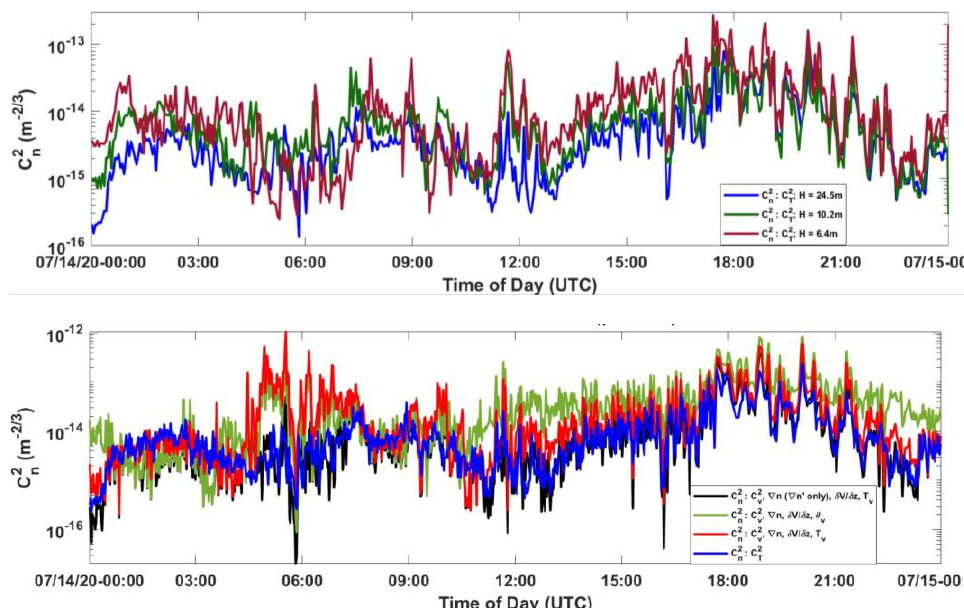
Figure 4. Top: profiles of C n2 at multiple points above the surface as extracted from calculations of the temperature structure constant, 𝐶 𝑇2 , using in situ point measurement of sonic temperature, 𝑇 𝑠 ; a three-minute ensemble averaging time is used for each of the plots. Bottom: C n2 from C T2 compared to C n2 from C v2 and the gradient of index of refraction in which the operative vertical temperature gradient is either θ v , T v , or T v but with the large scale T v vertical gradient removed per Equation (19). All plots are for 24.5 m and use a 90-second ensemble averaging time.